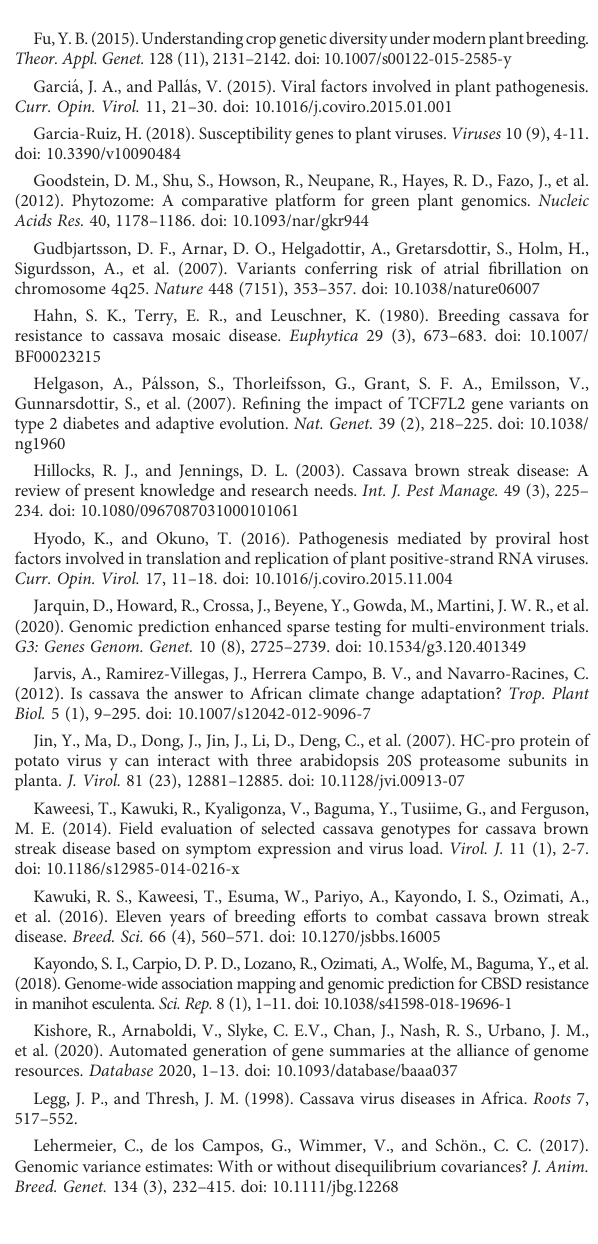
SUPPLEMENTARY FIGURE 2 QQplotsofunivariategenome-wideassociationstudiesforCBSDseveritytraits in the C2 population. A = cassava brown streak foliar severity at 3 MAP; B = cassava brown streak foliar severity at 3 MAP; C = cassava brown streak root severity. SUPPLEMENTARY FIGURE 3 QQ plots of multivariate genome-wide association studies for CBSD severity trait combinations in the C2 population. A = cassava brown streak foliar severity at 3 and 6 MAP; B = cassava brown streak severity at 3 and 12 MAP; C = cassava brown streak severity at 6 and 12 MAP; D = cassava brown streak severity at 3, 6 and 12